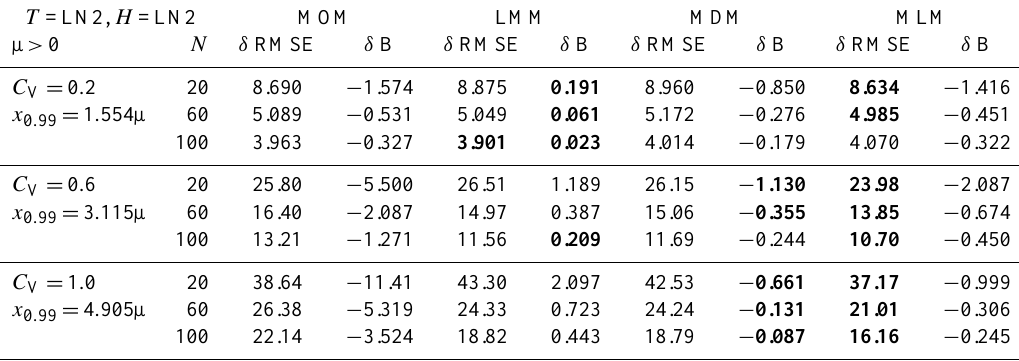
Table 3. Relative accuracy [ % ] of ˆ x 0 . 99 for a sample from LN2, assuming LN2 model.